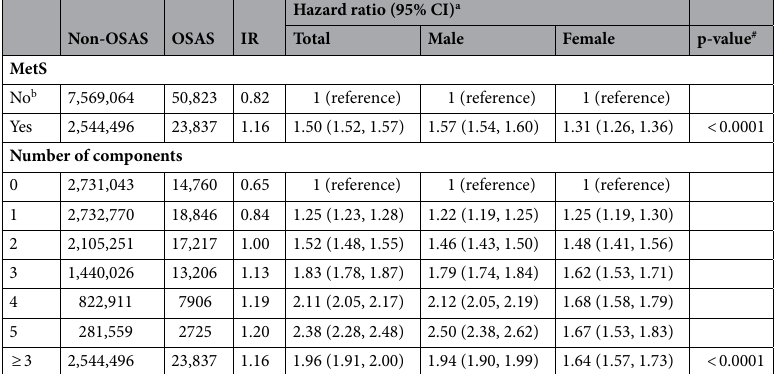
Table 2. Incidence rates and HRs of OSAS according to the number of MetS components, based on an adjusted multivariable analysis (for the period 2009–2018). IR; incidence rate (per 1,000), OSAS; obstructive sleep apnea syndrome, CI; confidence interval, MetS; metabolic syndrome. # p for interaction < 0.001 between male and female. a Adjusted for age, sex, smoking status, alcohol consumption, regular exercise, and body mass index. b Individuals who had 0–2 of MetS components.